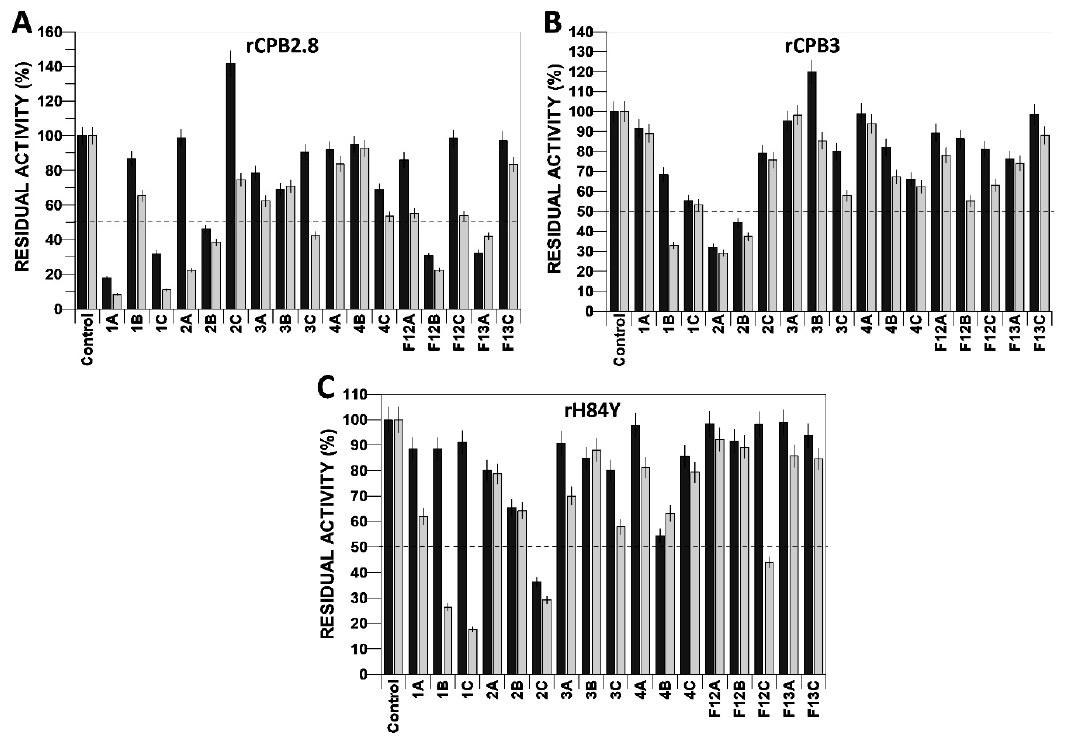
Figure 3. Screening of the action of compounds derived from chalcones and flavonoids on the enzymatic activity of the cysteine protease type B rCPB2.8 ( A ) of Leishmania mexicana and its isoforms rCPB3 ( B ) and rH84Y ( C ). Black column: 1 µM compound; grey column: 5 µM compound. Dotted line: delimits residual activity by 50%. Table 2. Chalcone inhibitory potential (IC 50 ) of chalcones to modulate the enzyme activity of Leishma- nia mexicana cysteine proteases rCPB2.8, rCPB3, and rH84Y.